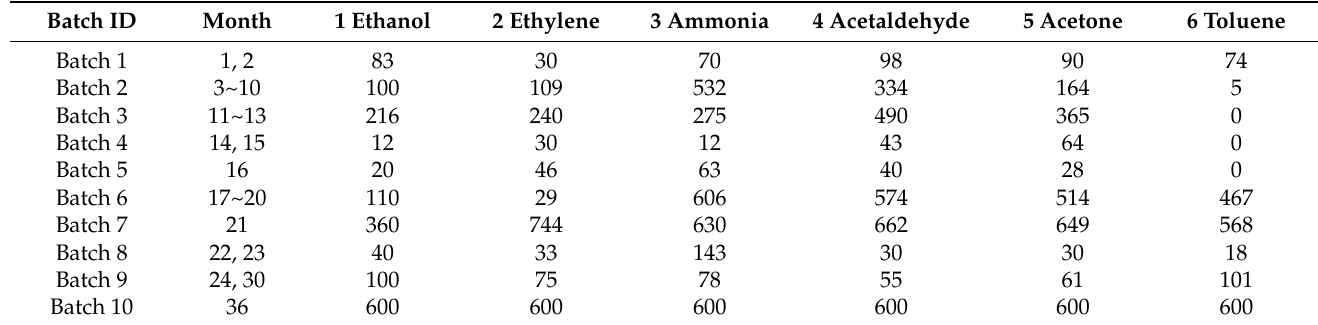
Table 1. Experimental data of sensor drift in MOS gas sensor array.